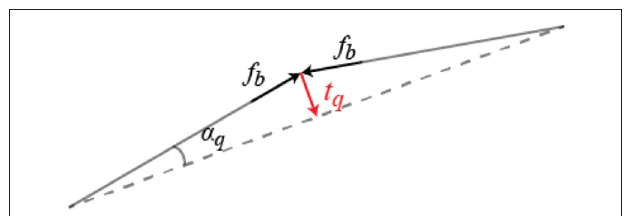
FIGURE 7 | The bar-string connection at complexity level q